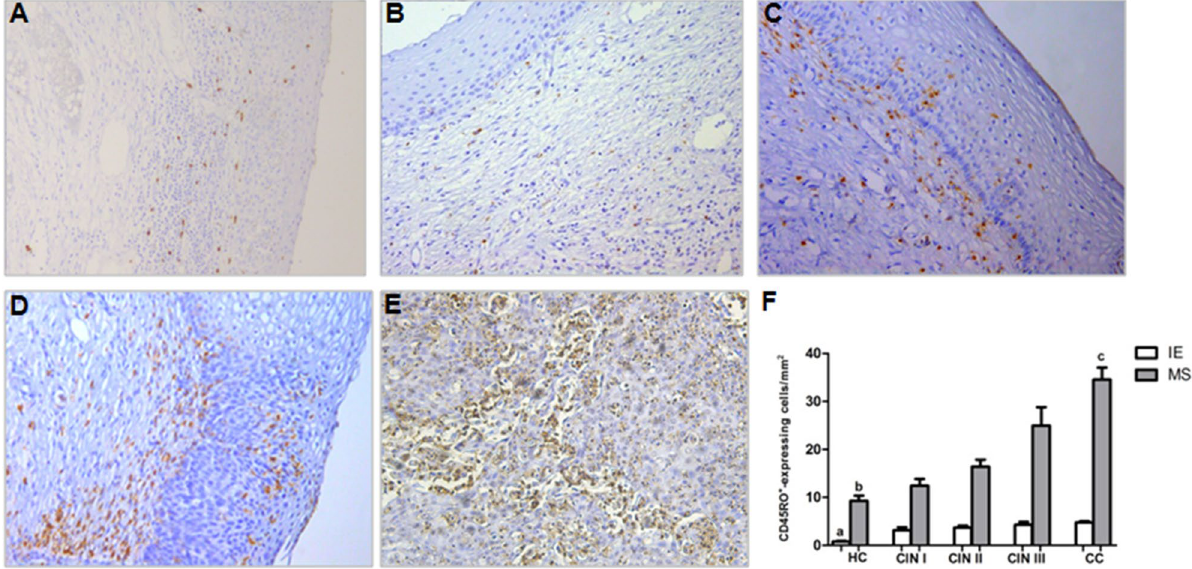
Figure 2. Immunohistochemical staining showing CD45RO + -expressing cells in uterine cervix tissues in IE and MS sites from ( A ) HC, ( B ) CIN I, ( C ) CIN II, ( D ) CIN III, and ( E ) CC. Original magnification = × 20, ( F ) represents the means ± SD of CD45RO expressing cell counts among the groups. a p < 0.05, HC versus CIN I; p < 0.001, HC versus CIN II, III and CC. b p < 0.01, HC versus CIN III. c p < 0.001, CC versus CIN I and HC; p < 0.01, CC versus CIN II. P value was calculated using the nonparametric Kruskal–Wallis test and post-test of Dunns for multiple comparisons.